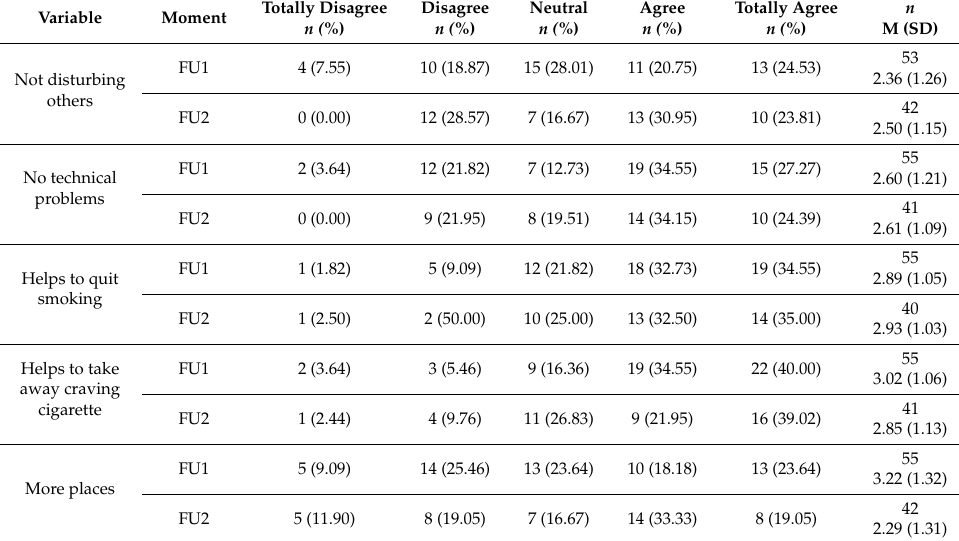
Table A3. Experienced benefits from vaping at FU1 and